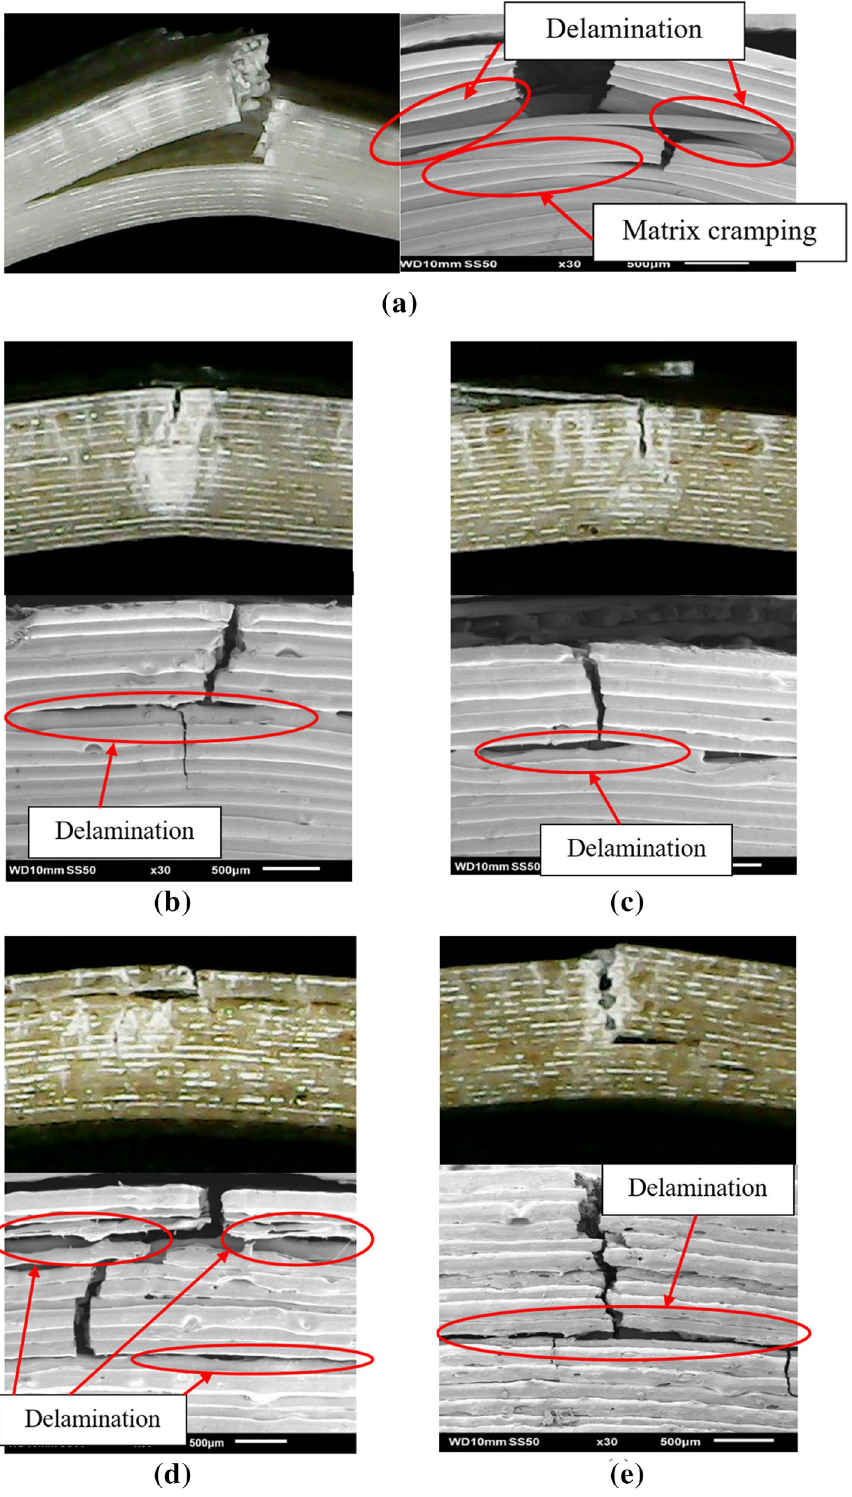
Fig. 9 Visual representation and SEM for flexural test. a 0% kenaf–ABS, b 2.5% kenaf–ABS, c 5% kenaf–ABS, d 7.5% kenaf–ABS, e 10%